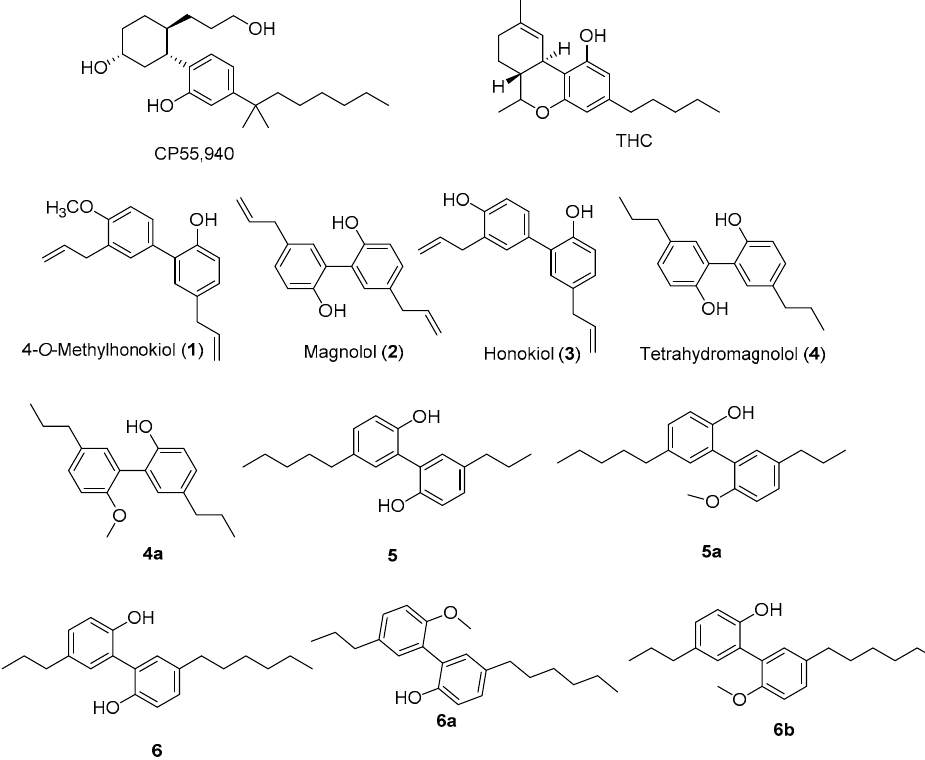
Figure 1. Compounds isolated/identified ( 1 – 4 ) from M. grandiflora seed and related ( 4a – 6b ) com- pounds [29] were used for molecular docking studies.